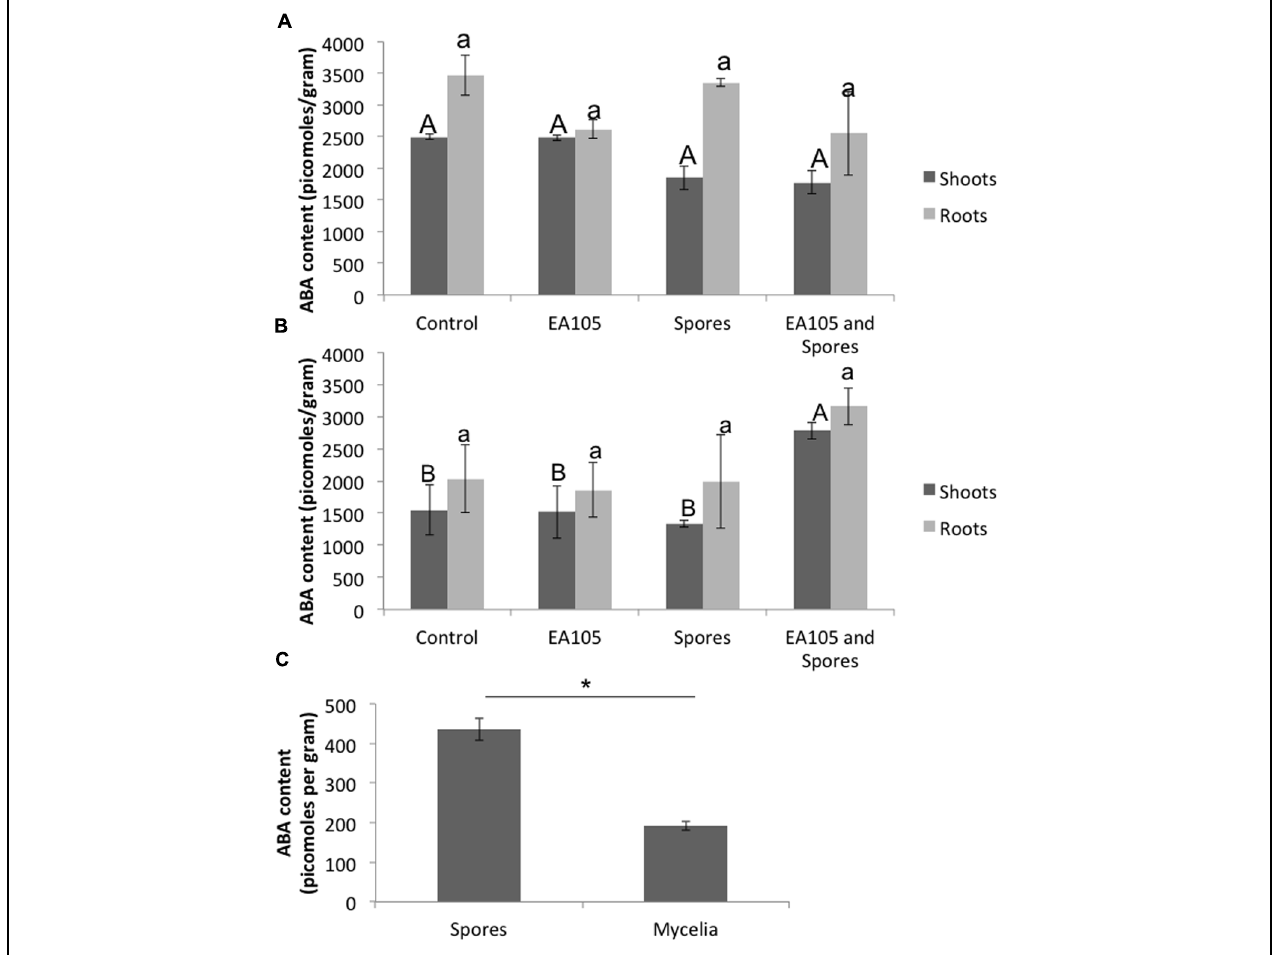
FIGURE 2 | Abscisic acid (ABA) concentrations in rice roots and shoots, as well as 70-15 spores and mycelia, using an ELISA-based kit. Root and shoot tissue was collected separately at (A) 24 h post 70-15 treatment and (B) 48 h post 70-15 treatment for ABA extraction. (C) ABA content was quantified in untreated 70-15 spores and mycelia. Error bars indicate standard error based on three biological replicates, each pooled from 5 plants, or 3 plates of fungi. Each replicate was quantified in quadruplicate. Different letters represent a statistically significant difference based on the Tukey-Kramer test when p < 0.05. For spores and mycelia, mean ABA concentration is statistically significant, p = 0.0036, based on a t